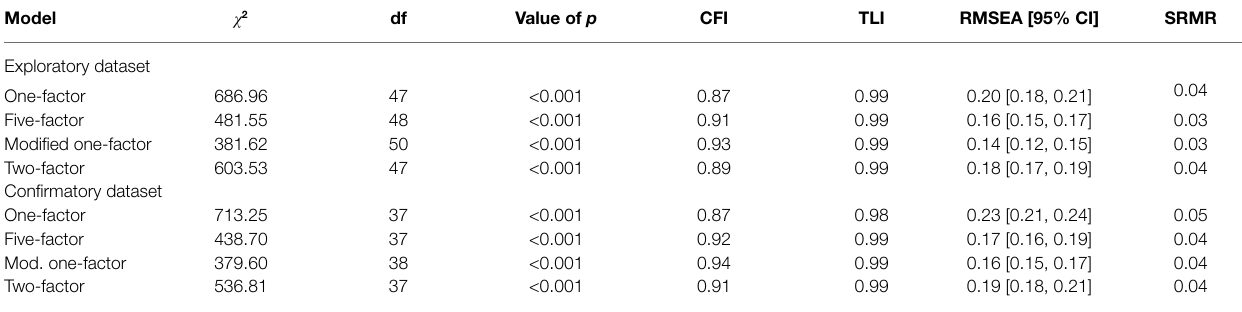
TABLE 4 | Model fit parameters (scaled) for both the exploratory and the confirmatory dataset.